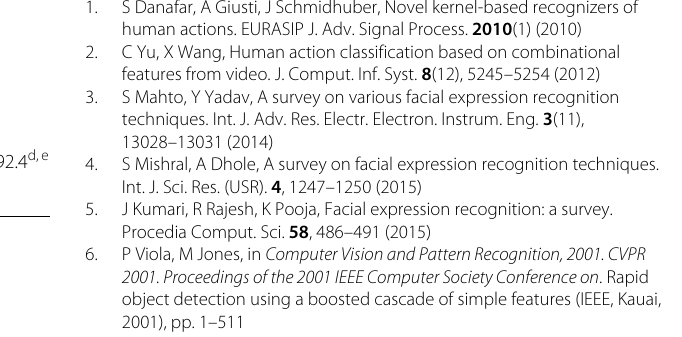
Table 19 Comparison of recognition rate (%) on CK dataset for various feature selection methods in literature Method a